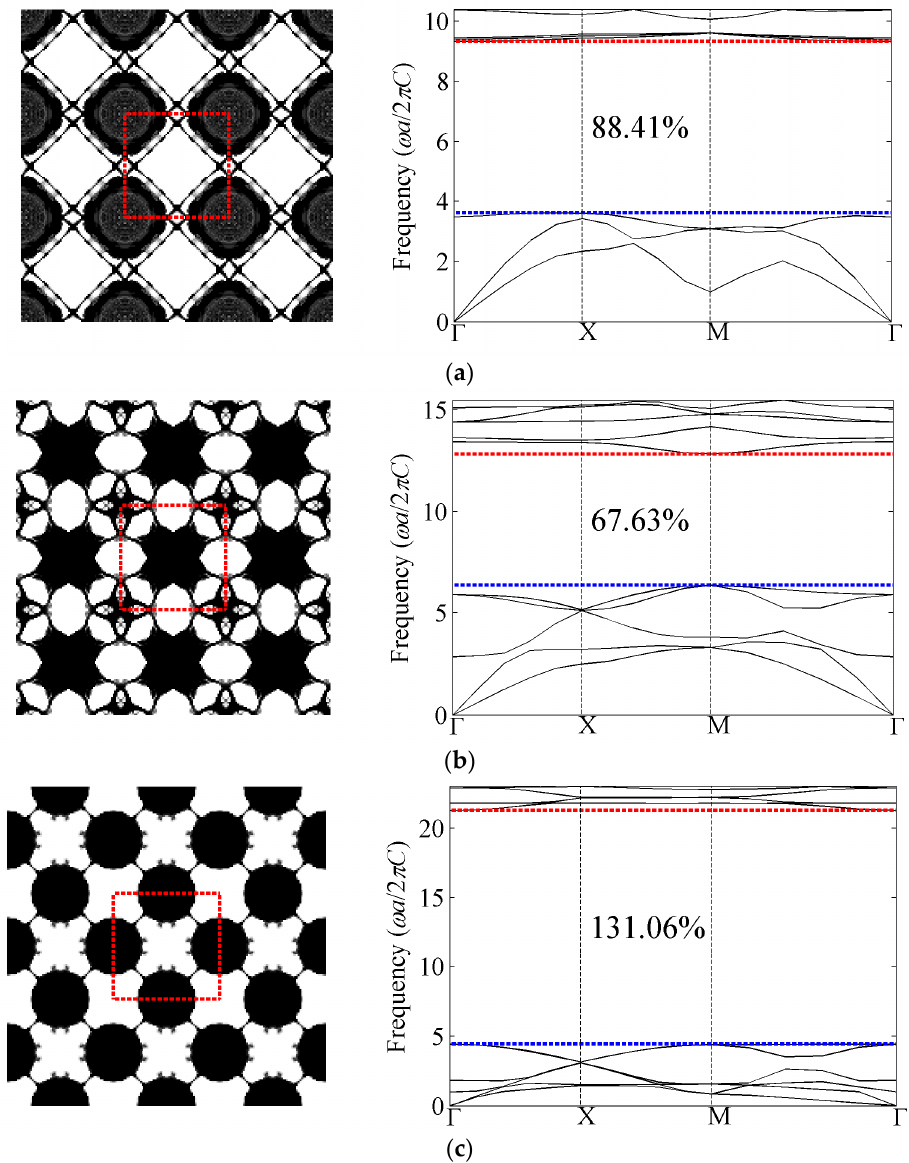
Figure 10. Optimized topologies and corresponding band structures for in ‐ plane mode with shear modulus constraint. ( a ) The third band gap; ( b ) the fifth band gap; and ( c ) the sixth band gap. Compared with results with bulk modulus constraint, the optimized topologies are